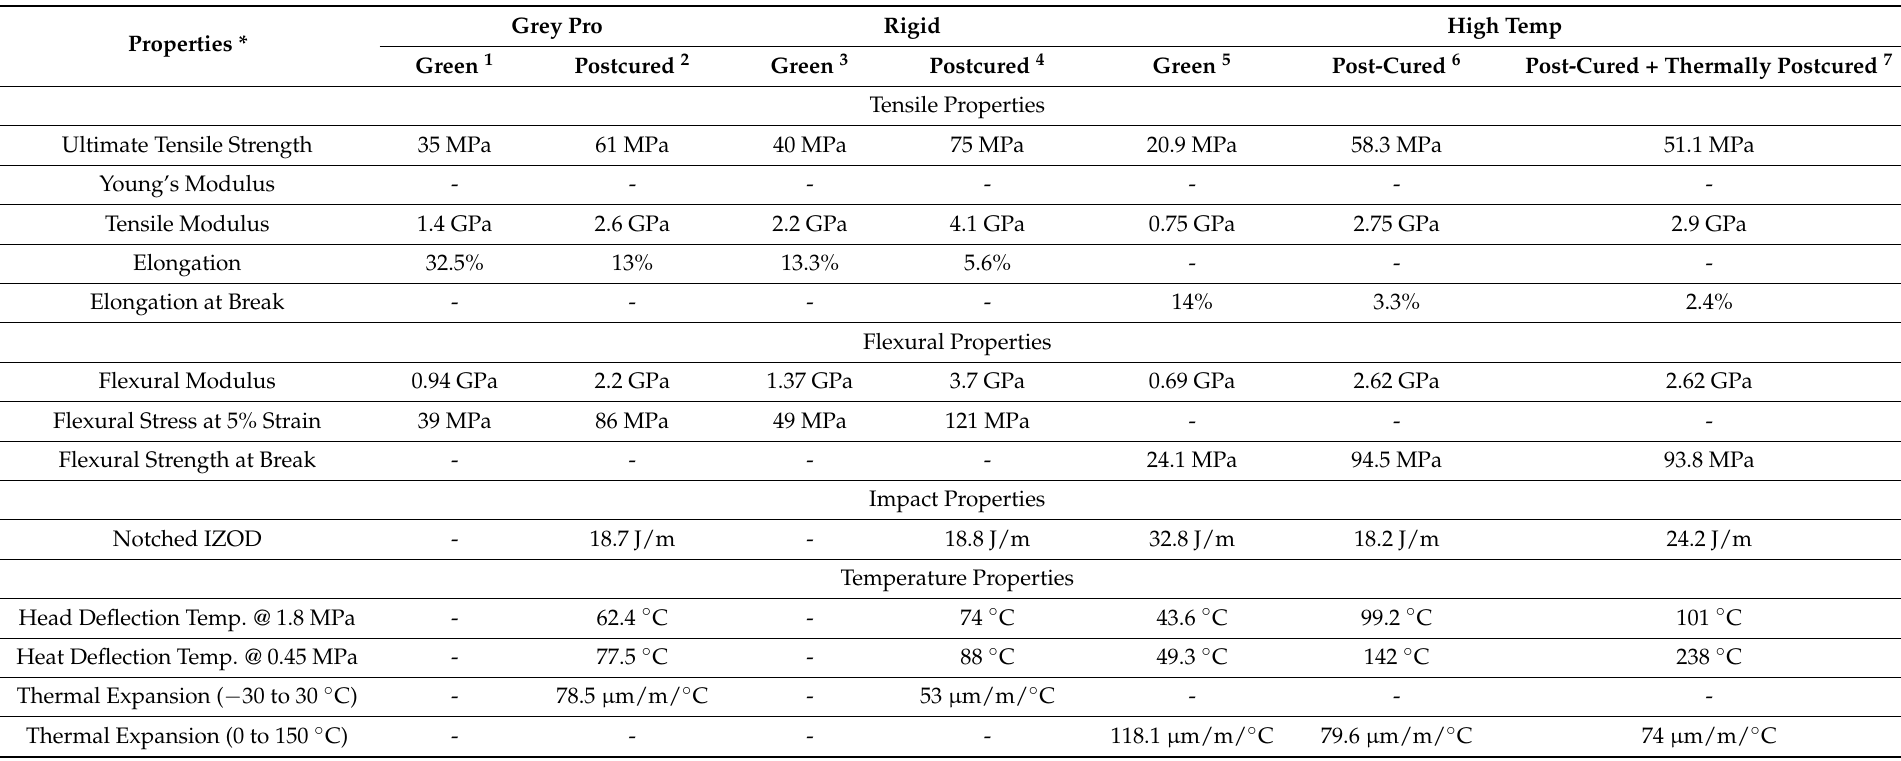
Table 2. Mechanical properties of structural resin